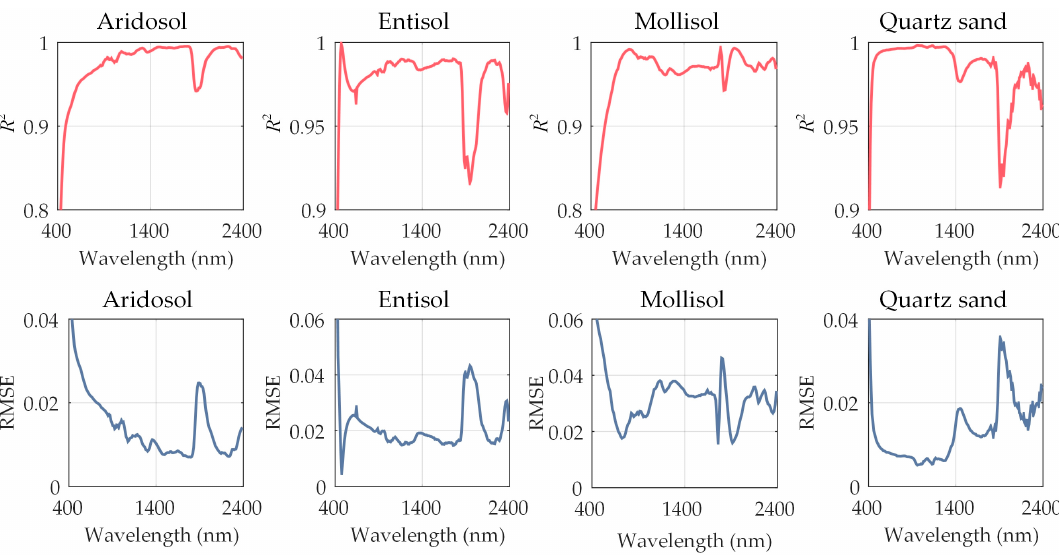
ff erent wavelengths.